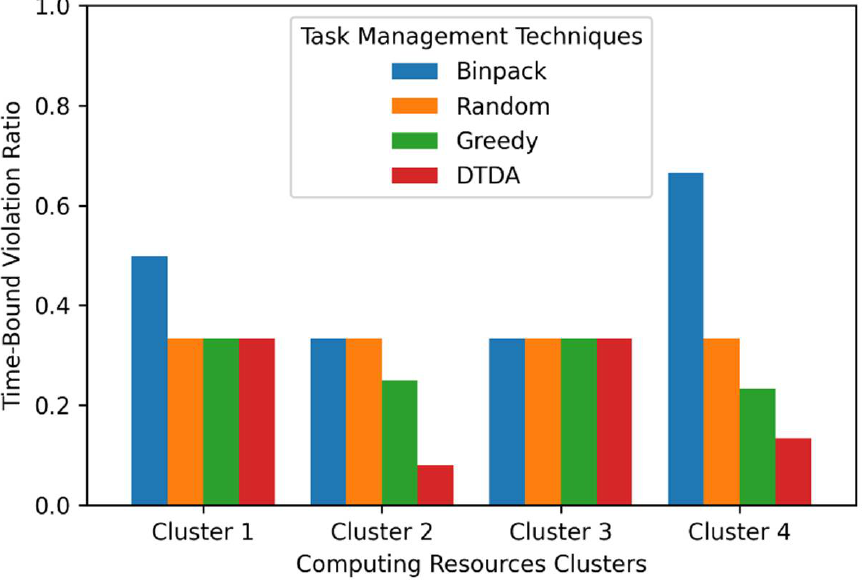
Figure 9. Comparison of time-bound requirement violation ratios under different computing re- sources clusters.